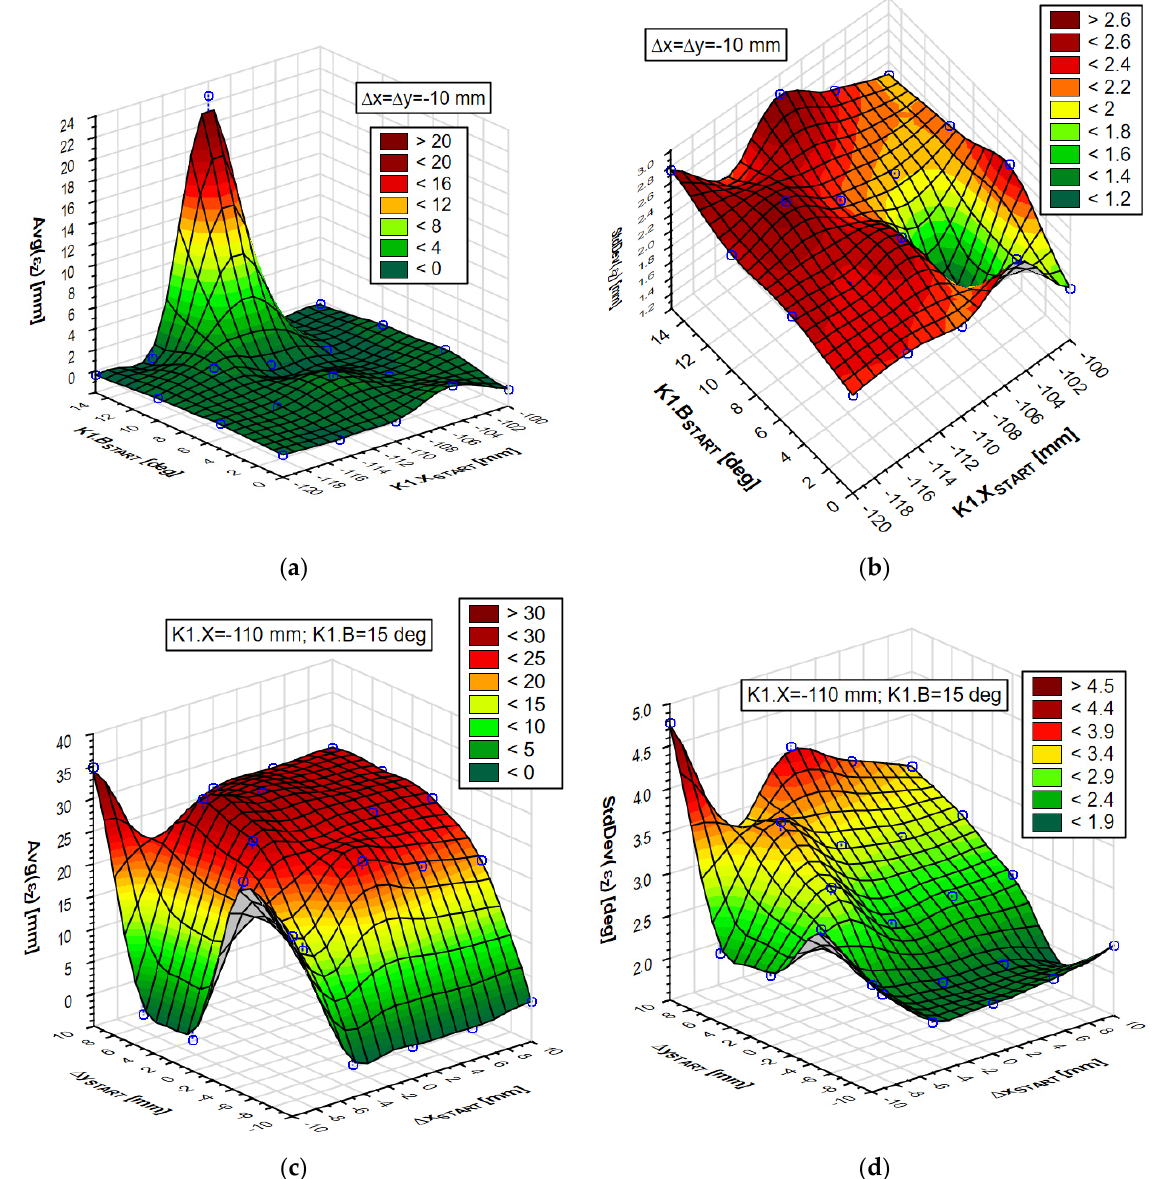
Figure 10. Influence of the initial values of the transformation parameters on the results of minimizing the objective function F 1 : dependence of the mean value ( a ) and standard deviation ( b ) on selected components of the translation and rotation vectors of the left camera coordinate system; dependence of the mean value ( c ) and standard deviation ( d ) on the displacement of the central point of the pattern.